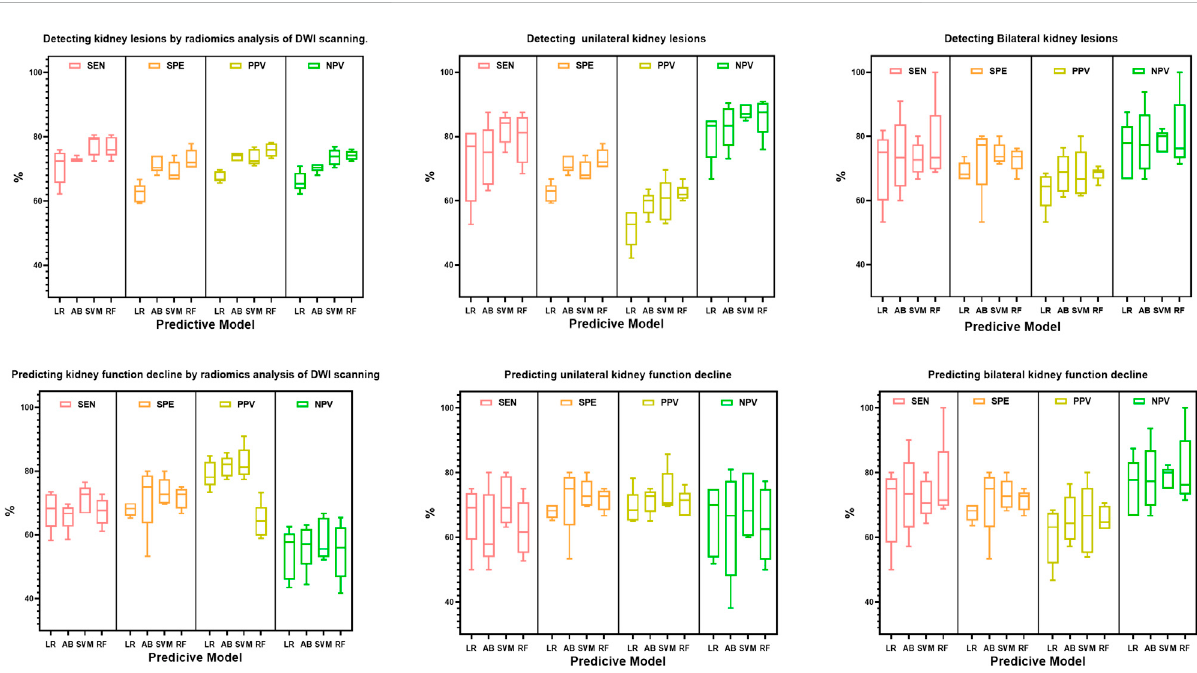
FIGURE 3 Box plot distributions of sensitivity (SEN), speci fi city (SPE), positive predictive value (PPV) and negative predictive value (NPV) under radiomics models for the prediction of bilateral or unilateral kidney lesions. The four machine learning classi fi ers including Logistic Regression (LR), AdaBoost (AB), Support Vector Machines (SVM) and Random Forest (RF) from the same splits of patients to train and test on DWI features.